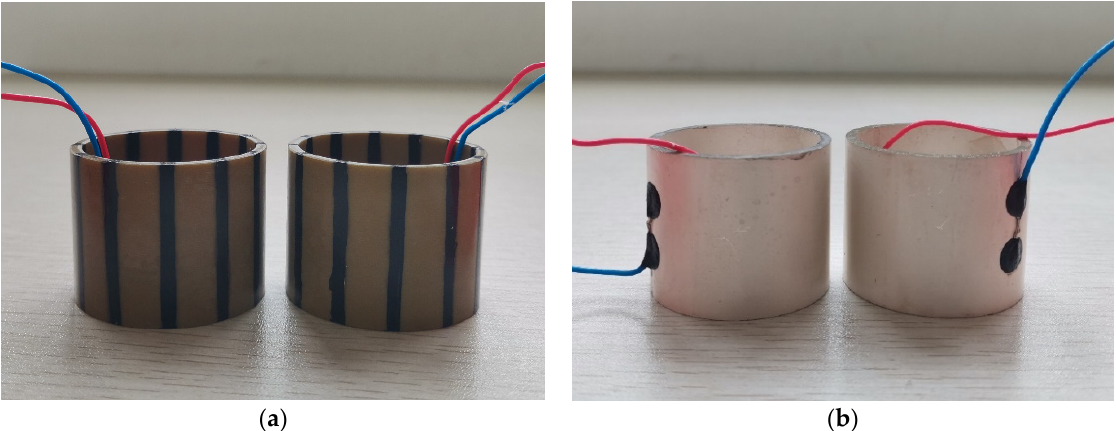
Figure 11. Thin cylindrical piezoelectric transducers, used in the experiments: the sides of the radially polarized thin cylindrical transducers are silvered. ( a ) Tangentially polarized thin cylindrical transducers; ( b ) Radially polarized thin cylindrical transducers.